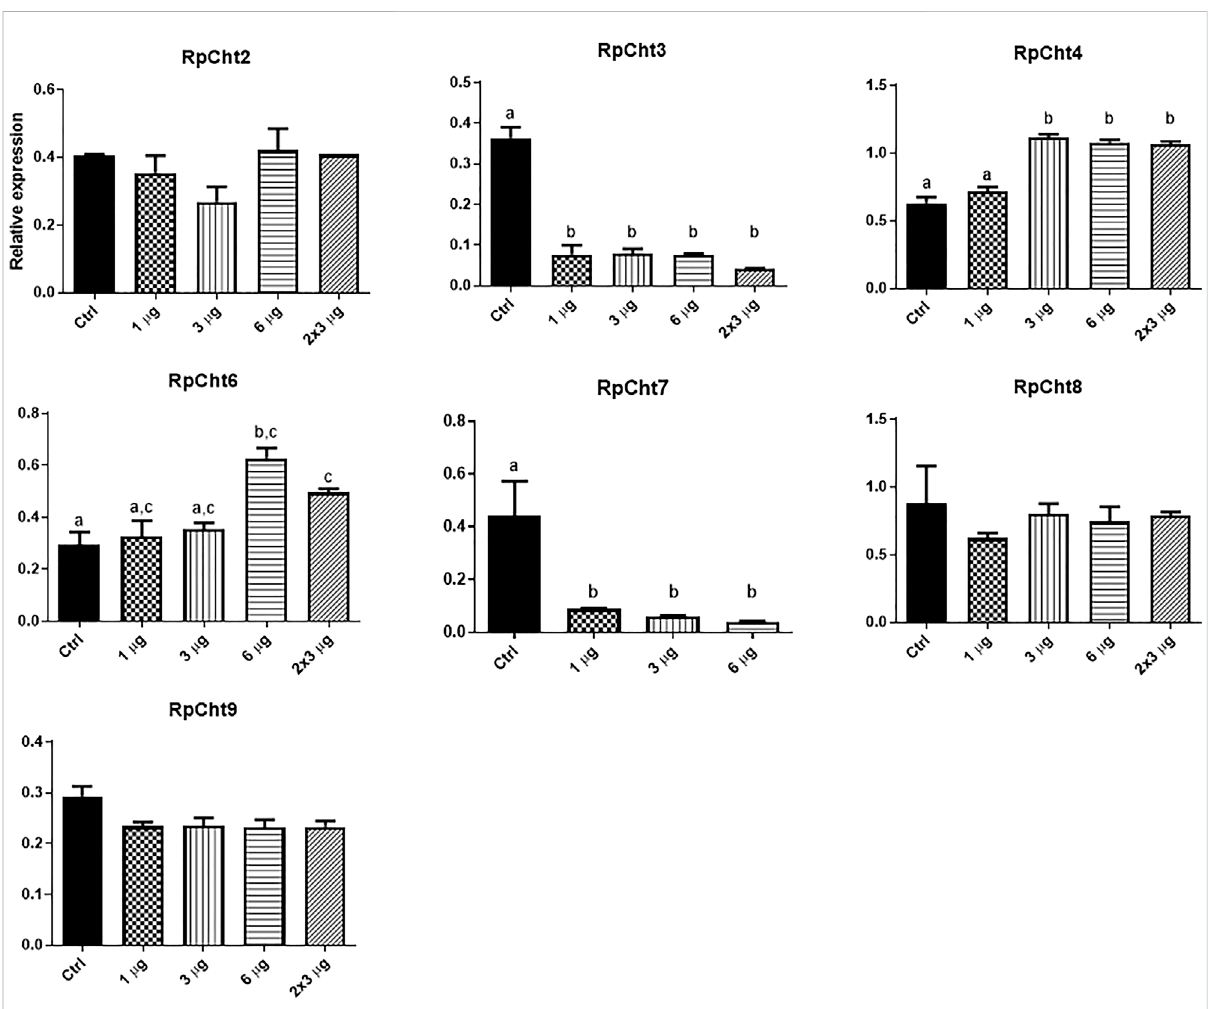
FIGURE 6 Knockdown screening of chitinase genes. Fifth instar nymphs of R. prolixus were injected into the hemolymph with dsRNA for GFP as control, and RpCht2 , RpCht3 , RpCht4 , RpCht6 , RpCht7 , RpCht8 and RpCht9 with 1 µg, 3 µg, 6 µg and two injections of 3 µg with a 24 h interval between them.RelativeexpressionusingActinasreferenceconstitutivegene,obtainedwiththeImageJprogram(bybanddensitometry).Valuesmarkedwith a, b and c correspond to signi fi cantly different groups * p < 0.0001 (one-way ANOVA – Tukey), N =